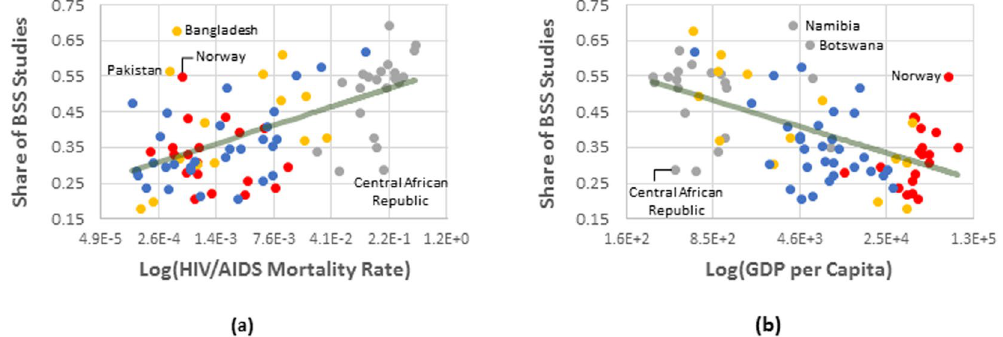
Figure 5. BSS focus of publications from different countries (average during the period 2006 to 2010) compared to their HIV/AIDS mortality rate in 2005 and GDP per capita (average during 2006 to 2010). Each dot corresponds to a country (Red: North America & Western Europe; Yellow: Southern & Southeast Asia; Gray: Sub-Saharan Africa; Blue: Rest of the world). The solid lines show the correlation lines. Countries that are two standard deviation further from the correlation line are